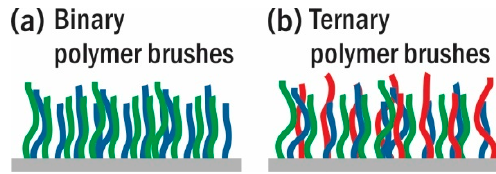
Figure 1. Schematic illustration of binary and ternary MPBs.